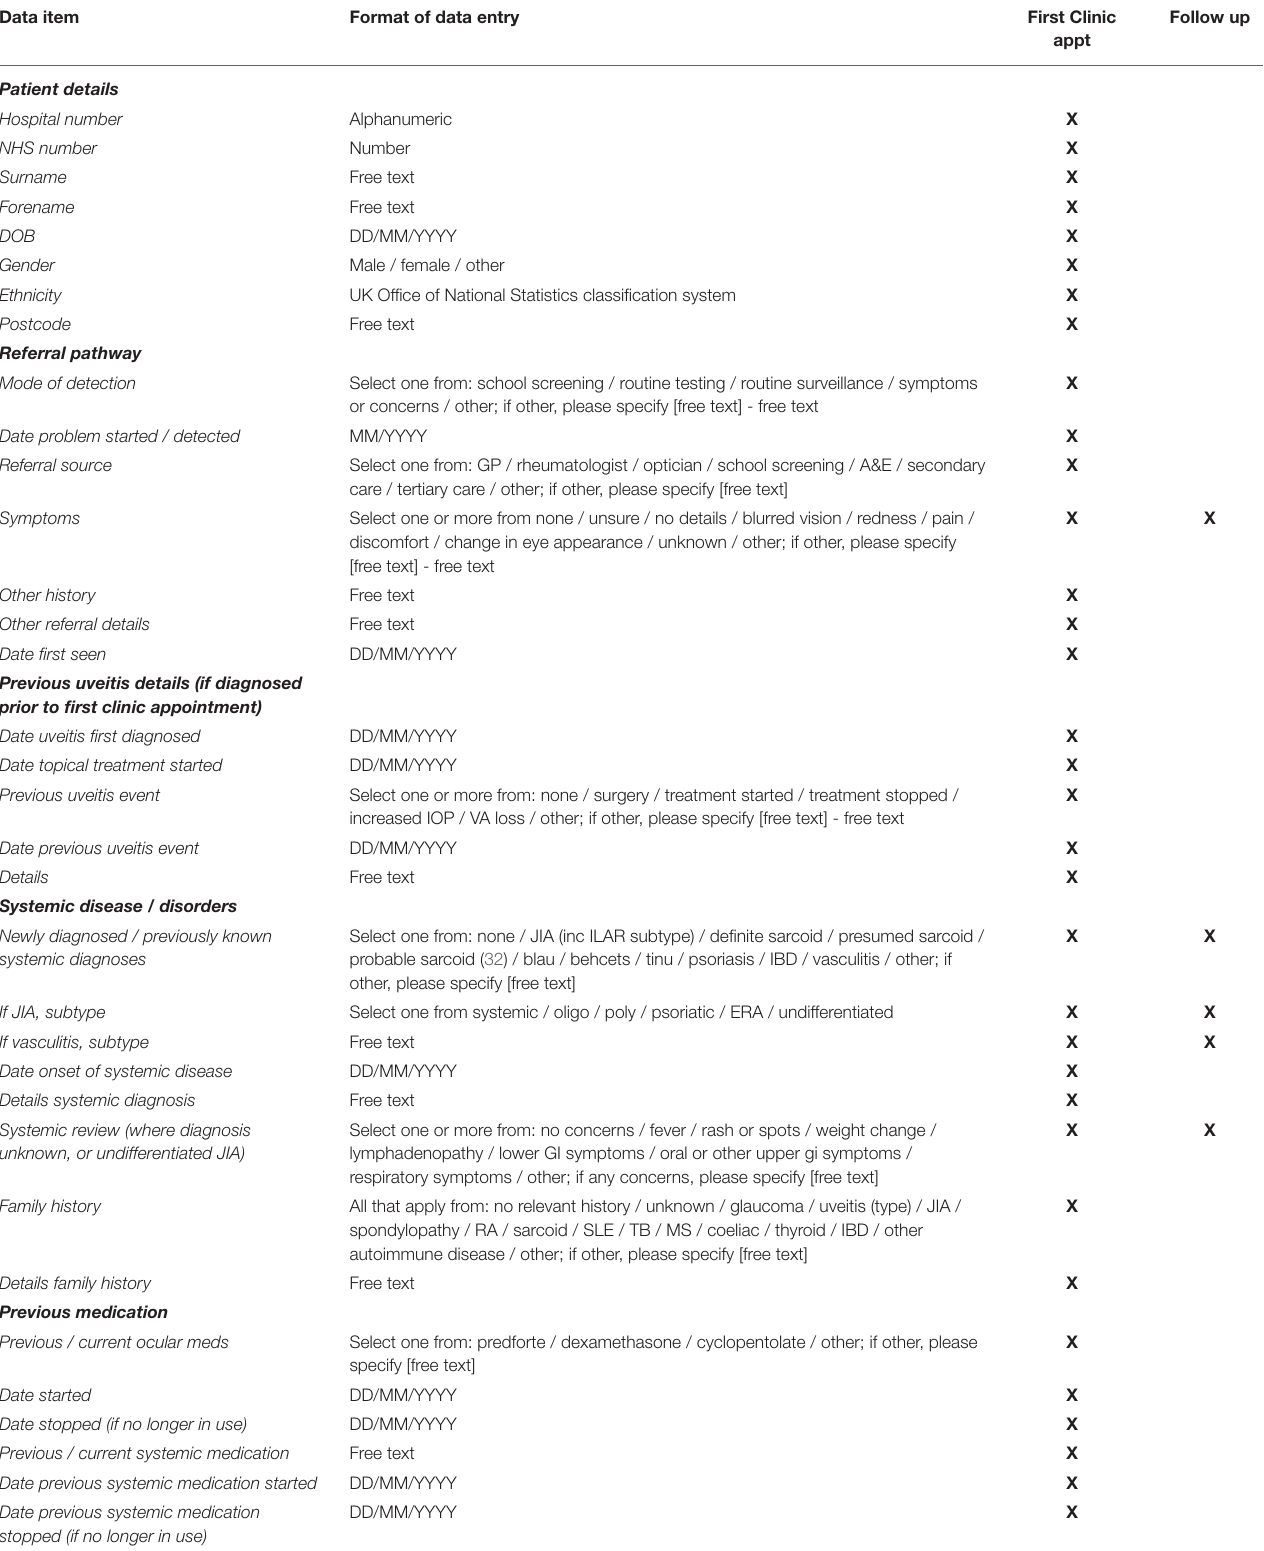
TABLE 1 | Core clinical dataset for childhood